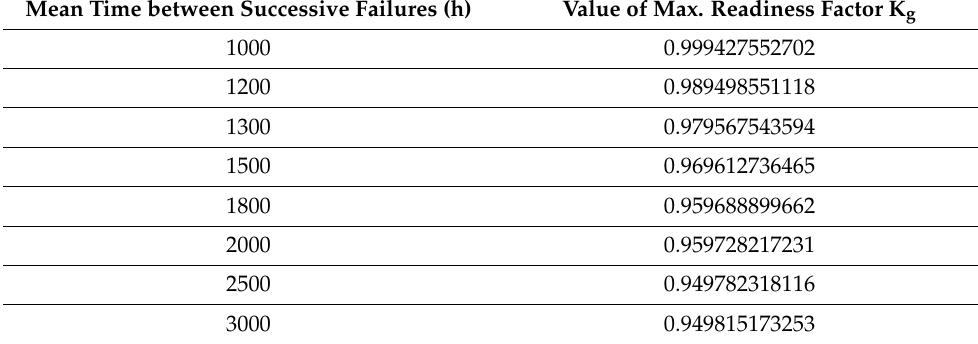
Table 2. Max. value readiness factor K g